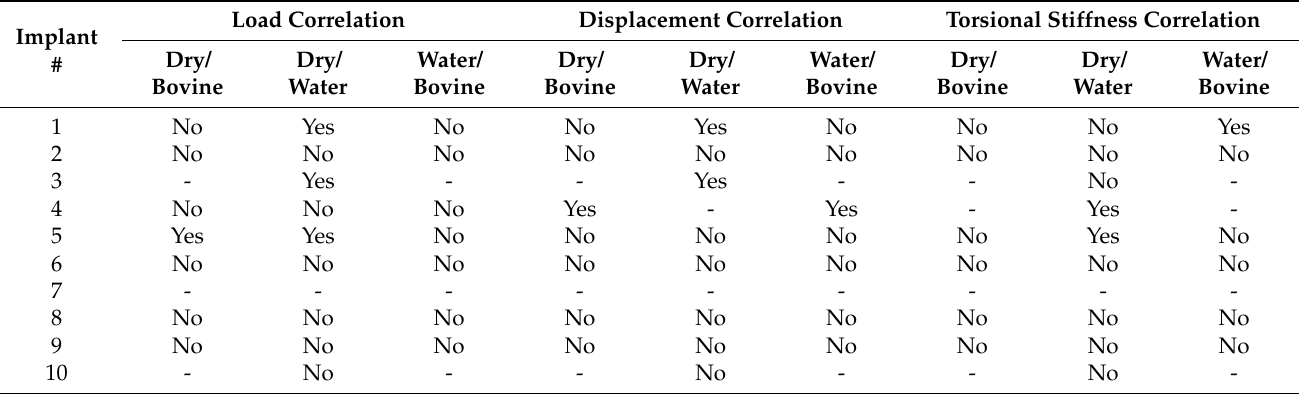
Table 6. The p -value correlations of three different taper conditions.